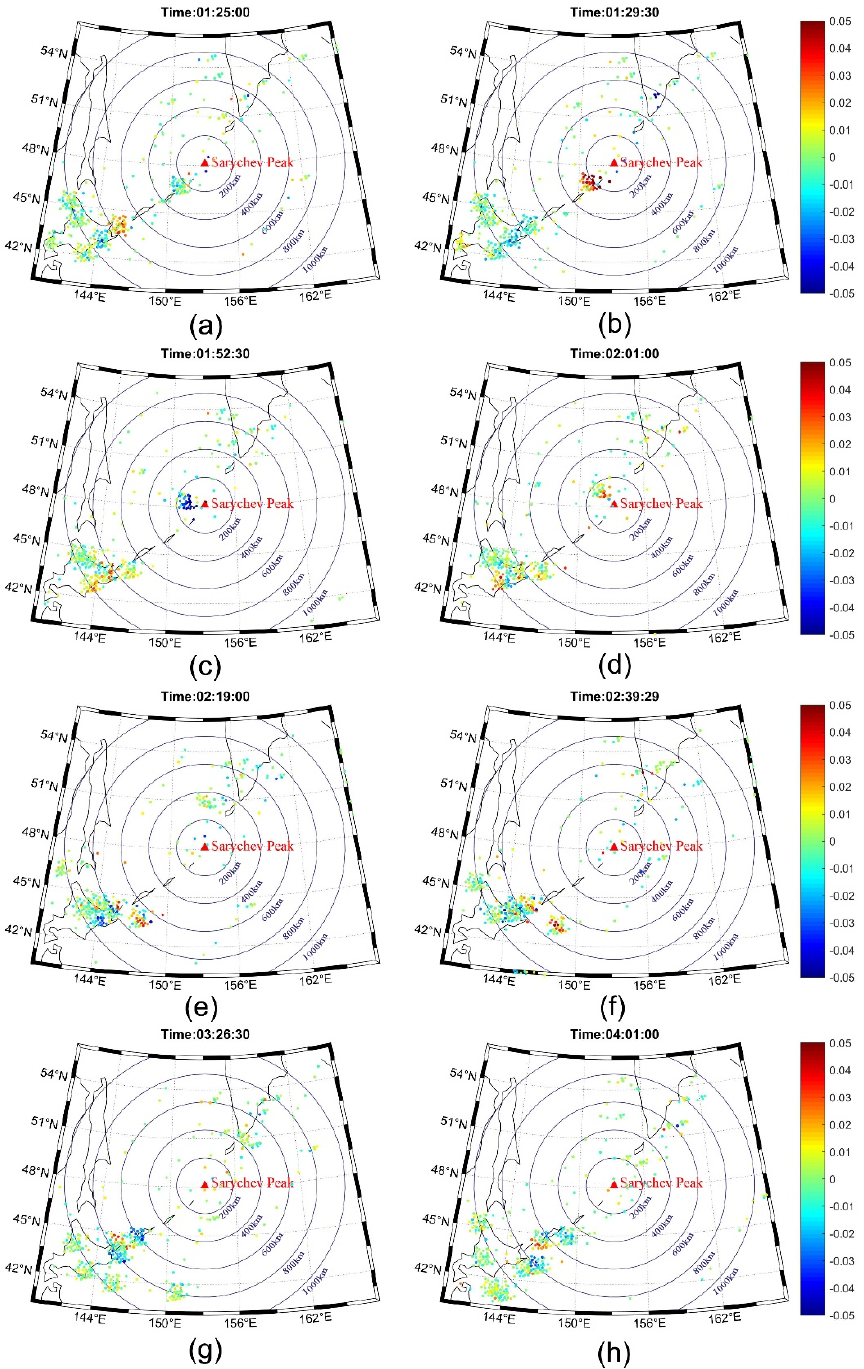
Figure 9. Examples of spatiotemporal evolution of the observed TEC disturbances invoked by 01:15 UT explosion of Sarychev Peak volcano. ( a ) The background TEC variations without visible CVIDs. ( b – d ) The near-field zone covolcanic TEC variation samples. ( e – h ) The far-field zone covolcanic TEC variation examples. The red triangle shows the location of Sarychev Peak volcano. The movie illustrating CVIDs propagation is given by Animation